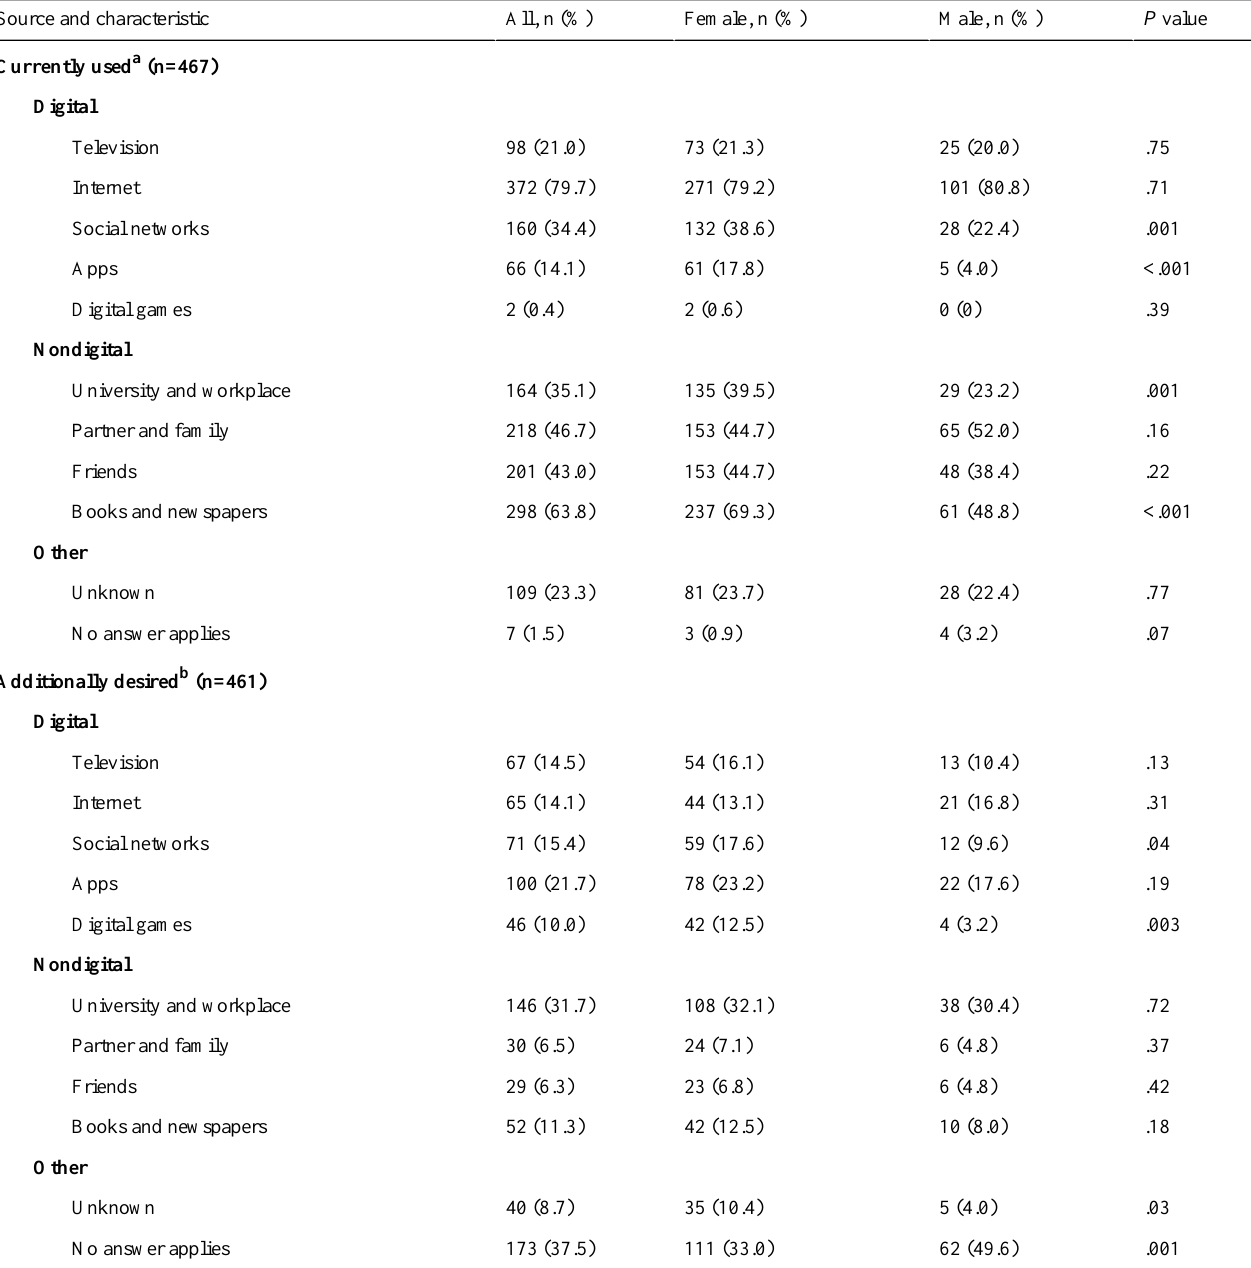
Table 2. Digital and nondigital sources of nutritional information (multiple responses